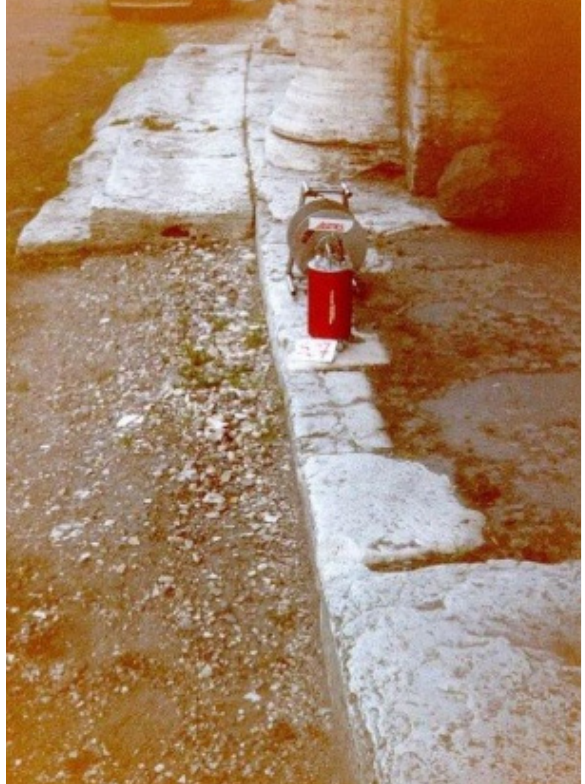
Figure 15. Vertical seismometer S27 in configuration C4.